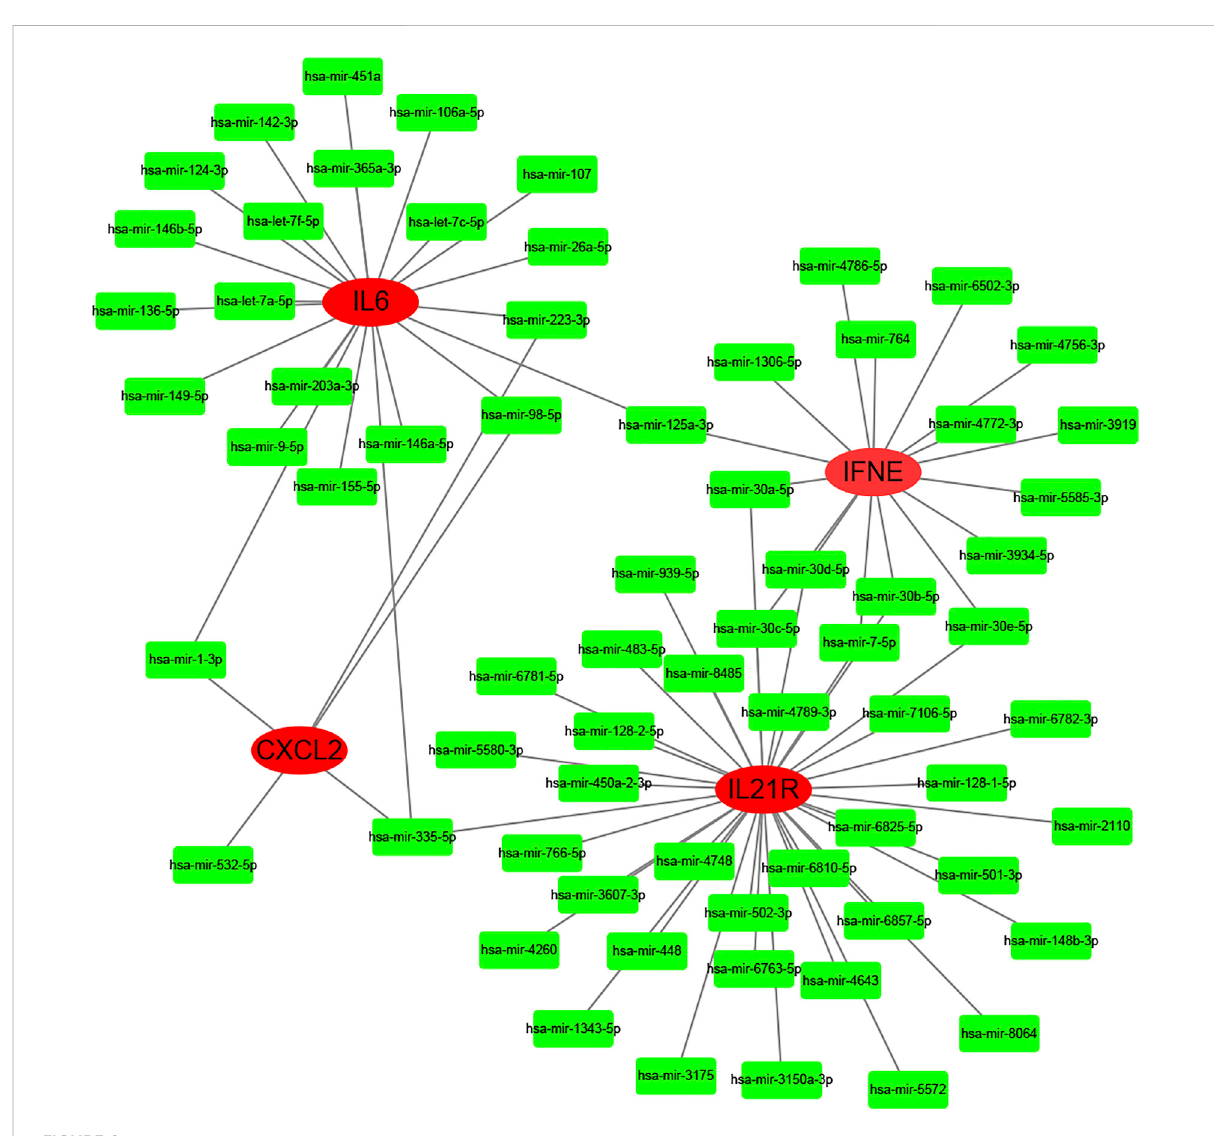
FIGURE 9 The interactions among the 4 core genes and their target